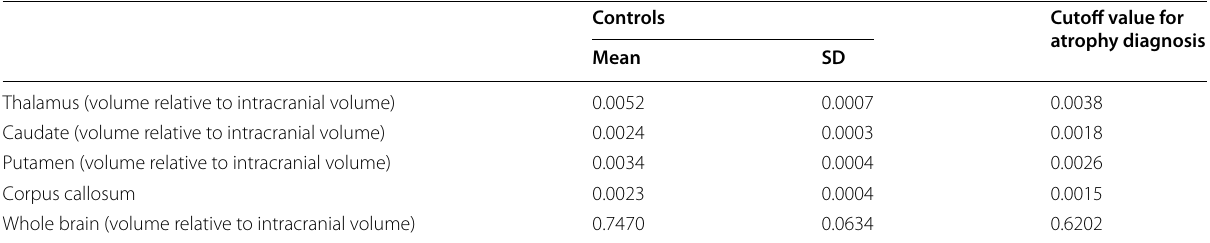
Table 5 Cutoff value for diagnosis of atrophy of thalamus, whole brain, caudate, putamen and corpus callosum